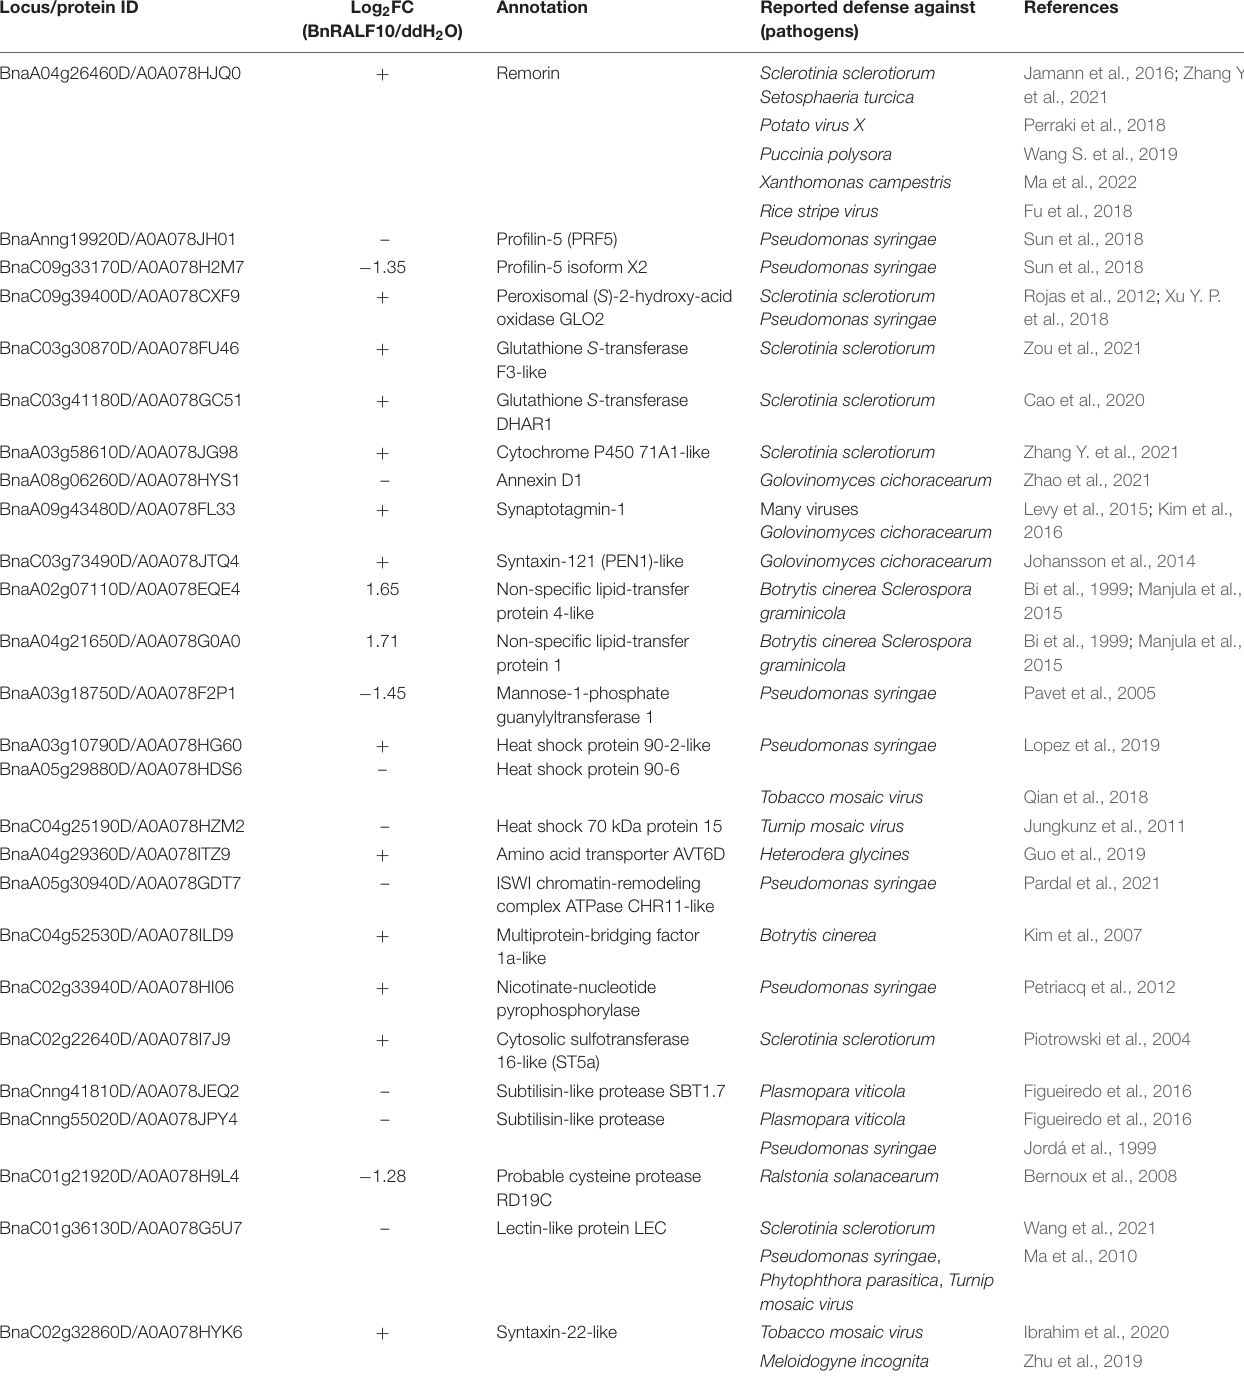
TABLE 2 | List of functionally proved BnRALF10-elicited defense (RED) proteins. Locus/protein